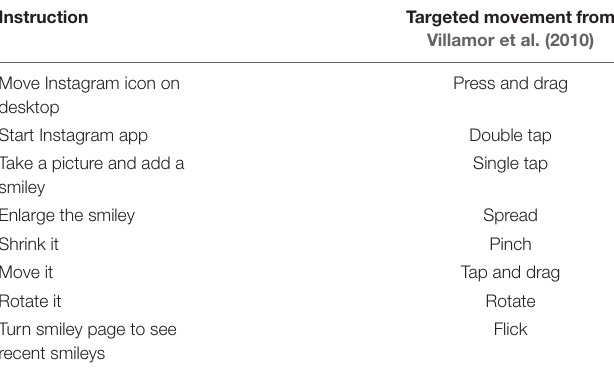
TABLE 1 | Description of the functioning task procedure according to the touch gesture reference guide (Villamor et al., 2010).